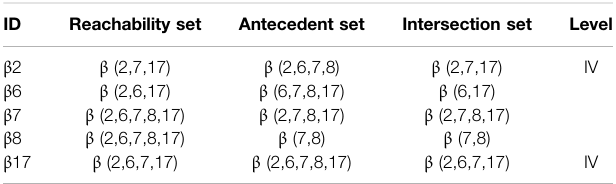
TABLE 10 | Partition level IV.